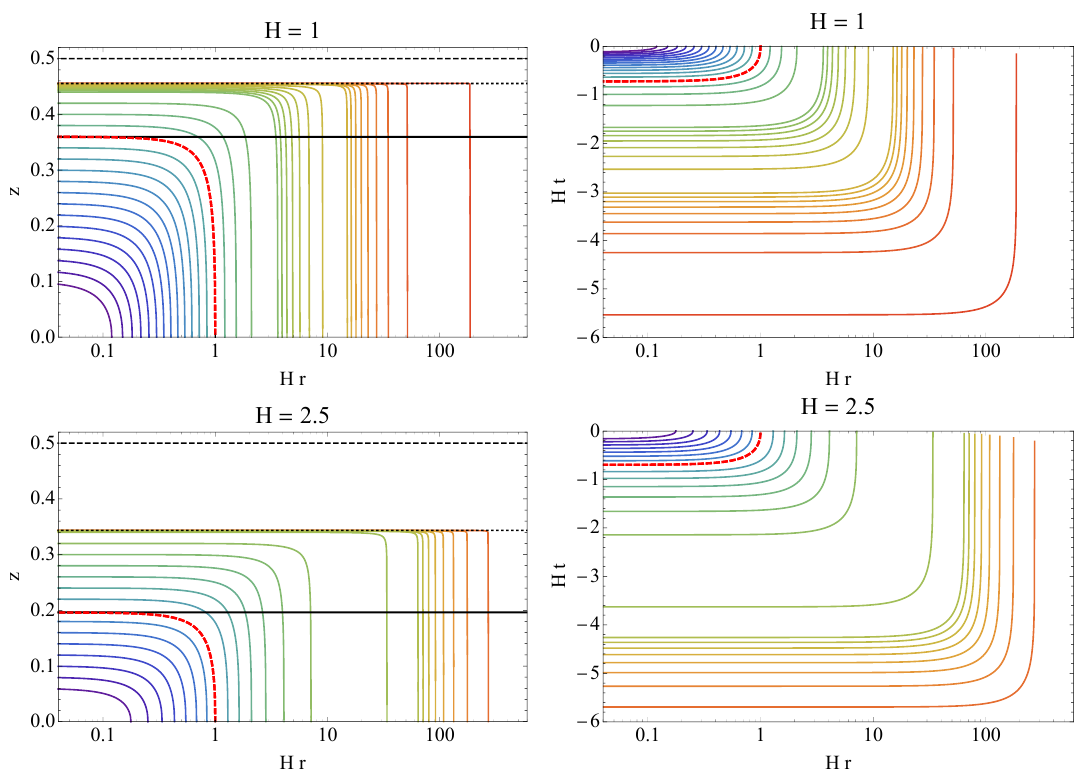
Figure 10 . Extremal surfaces with various values of z ∗ in the z − r plane (left) and t − r plane (right) for H = 1 (top) and H = 2 . 5 (bottom). Solid, dotted and dashed black lines indicate the radial location of event, entangling and apparent horizon, respectively. Red dashed curves are extremal surfaces with z ∗ = z EH which end on the boundary precisely at the location ( r = 1 /H ) of the cosmological